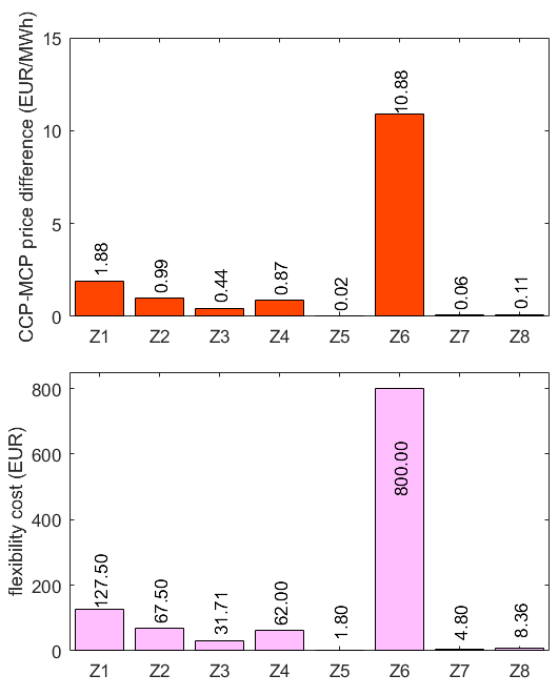
Figure 8. Illustration of the payment redistribution technique for the first simulated scenario.